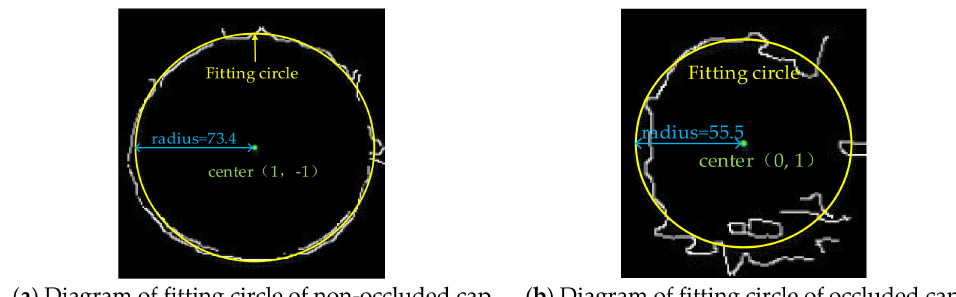
Figure 8. Schematic diagram of the best-fitting